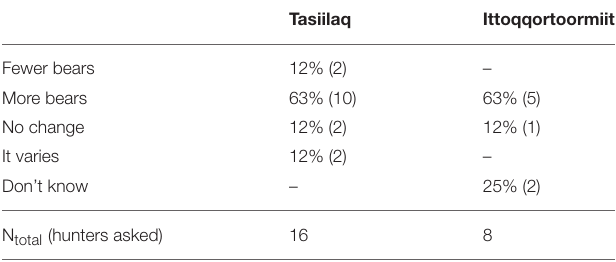
TABLE 4 | Distribution of responses to question 34: “Have there been changes in the past 10–15 years in the number of polar bears in areas where you are hunting them?” Tasiilaq